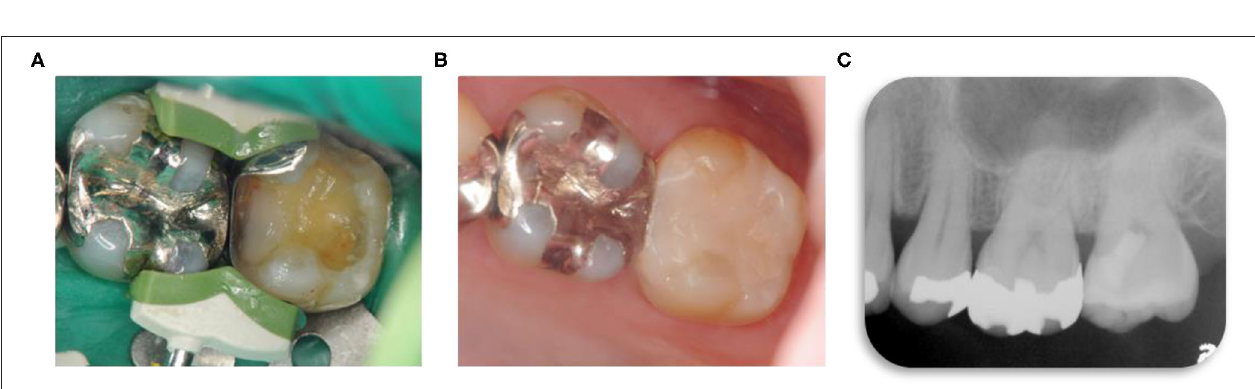
FIGURE 3 | Reentry clinical images extracted from clinical videos during the second visit. Videos are available online at doi: 10.6084/m9.figshare.13228661 as Supplemental Materials. (A) Radiographic image ∼ 6 months after the first visit. There is no significant change in periapical tissue, and hard tissue formation is evident beneath the hydraulic-calcium-silicate cement (HSCS). (B) ProRoot MTA cement exposed after removing the temporary sealing. Black discoloration is observed at the periphery of the material between the cement and the dentin. (C) After removal of the ProRoot MTA cement, hard tissue formation was observed beneath the exposed pulp. Black arrows indicate defects. (D) Exposed pulp and hard tissue were redressed with ProRoot MTA cement. (E) Radiographic image after reentry. The hard tissue formation observed under the dental microscope is not clear on this radiographic image. HCSC volume is visibly higher compared with the first dressing.